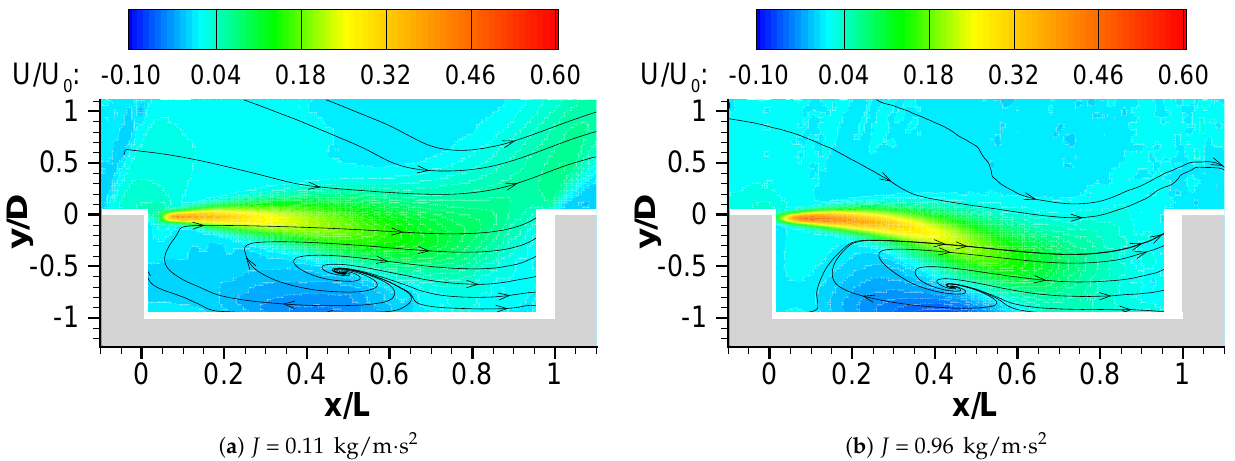
Figure 5. Time-averaged velocity streamlines and U / U 0 contours for actuator with the cavity model [quiescent condition] with different J